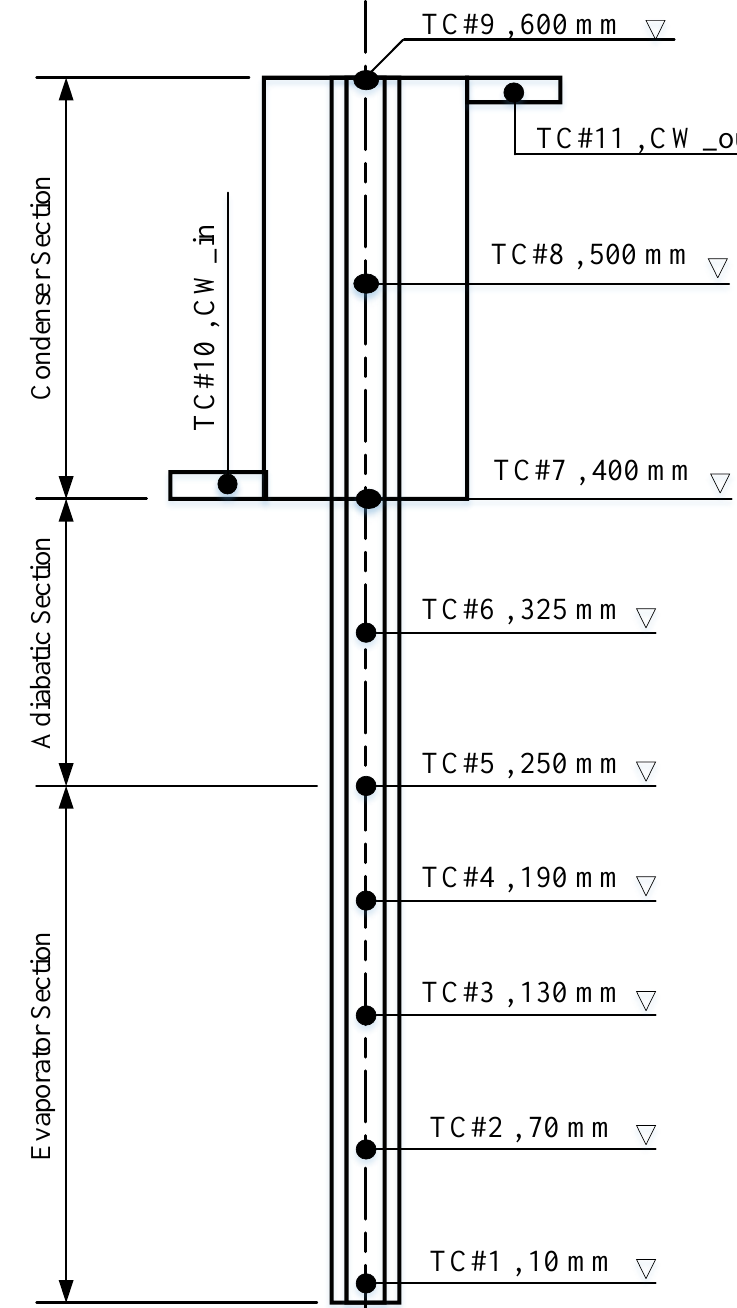
Figure 4. Thermocouple locations on the axis of both the THP and TPTHP.